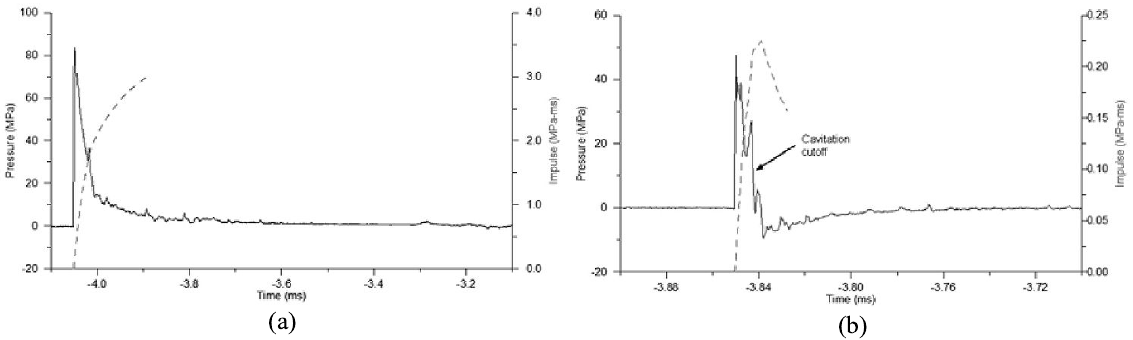
Fig. 2. Shock pressure histories: a) free-field, b) on plate surface. Dashed lines represent impulse.